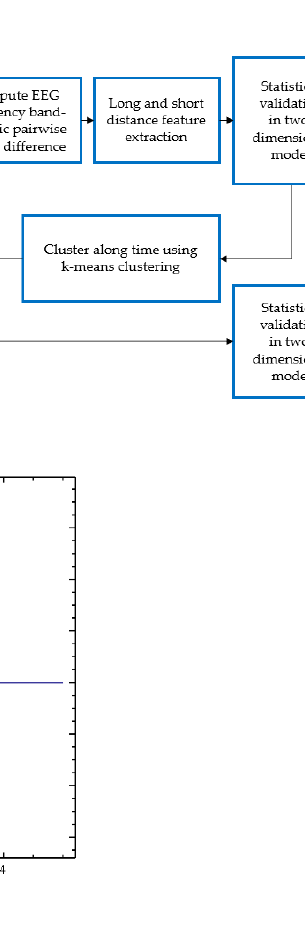
Figure 4. The Morlet wavelet graph.